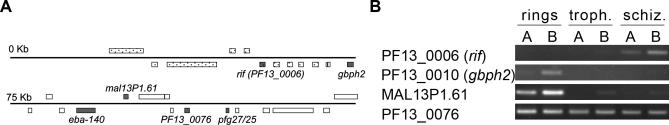
Expression of Genes Located in the Left Subtelomeric Region of Chromosome 13(A) Schematic of the genes in the left end of Chromosome 13, as annotated in PlasmoDB. Genes above the line are transcribed towards the centromere, whereas genes below the line are transcribed towards the telomere. The genes analysed by RT-PCR are highlighted in grey, with their names. Members of the var, rif, and stevor families are spotted.(B) RT-PCR analysis of RNA from rings, trophozoites, or schizonts of 3D7-A (lanes A) and 3D7-B (lanes B). The cDNA preparations used were the same as in Figure 5D. Thus, the controls for the amount of stage-specific cDNAs in Figure 5D also apply here.